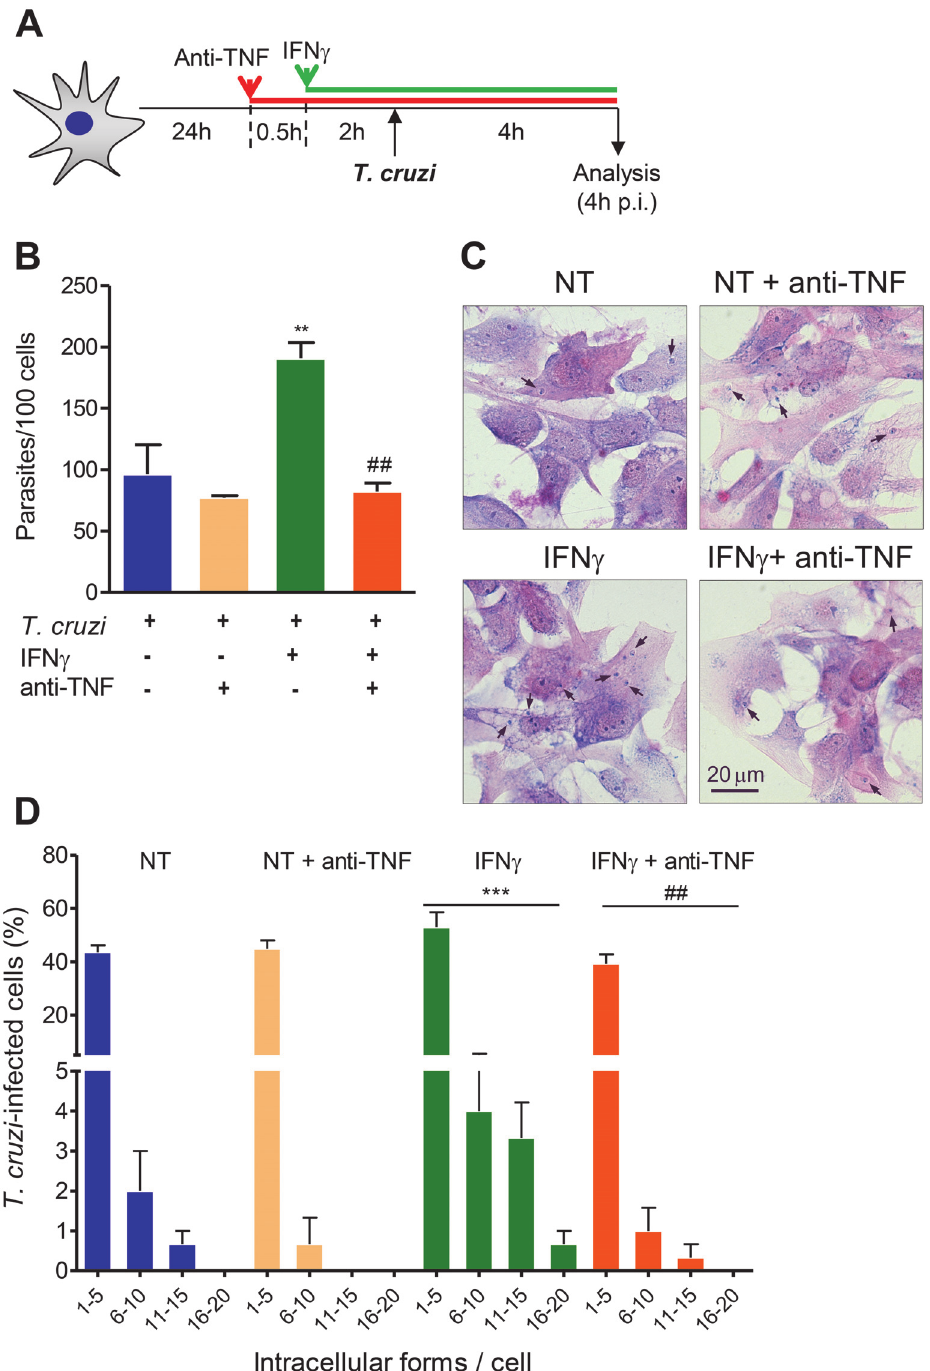
Fig 6. Anti-TNF antibody prevented the effects of IFN γ on infection of astrocytes by T. cruzi . (A) Primary astrocyte cell cultures were treated or not with IFN γ (10 ng/mL) in the absence or presence of anti-TNF (10 μ g/mL), infected using MOI 10:1, and analyzed 4 hours post-infection (p.i.). (B) Graph shows the mean number of parasites per 100 cells. (C) Representative pictures of IFN γ pretreated astrocytes and infected in the absence or presence of anti-TNF. (D) The graph shows the frequencies of T. cruzi -infected cells bearing different numbers of intracellular forms of the parasite. Data are presented as mean ± SEM of triplicates. ** , p < 0.01 and *** , p < 0.001 comparing IFN γ -pretreated astrocytes with not-treated (NT) cells; ## , p < 0.01 comparing IFN γ pretreated astrocytes in absence or presence of